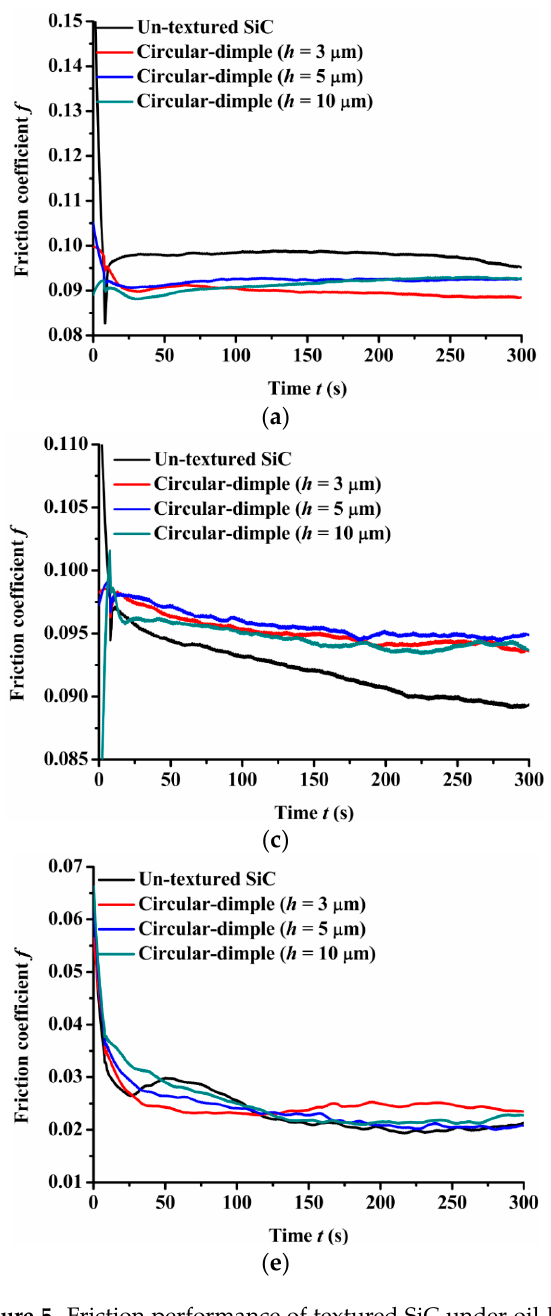
Figure 5. Friction performance of textured SiC under oil-lubricated conditions with a load of 75 N: ( a ) circular-dimple- textured SiC–steel ball; ( b ) groove-textured SiC–steel ball; ( c ) circular-dimple-textured SiC–Si 3 N 4 ball; ( d ) groove-textured SiC–Si 3 N 4 ball; ( e ) circular-dimple-textured SiC–PTFE ball; ( f ) groove-textured SiC–PTFE ball.